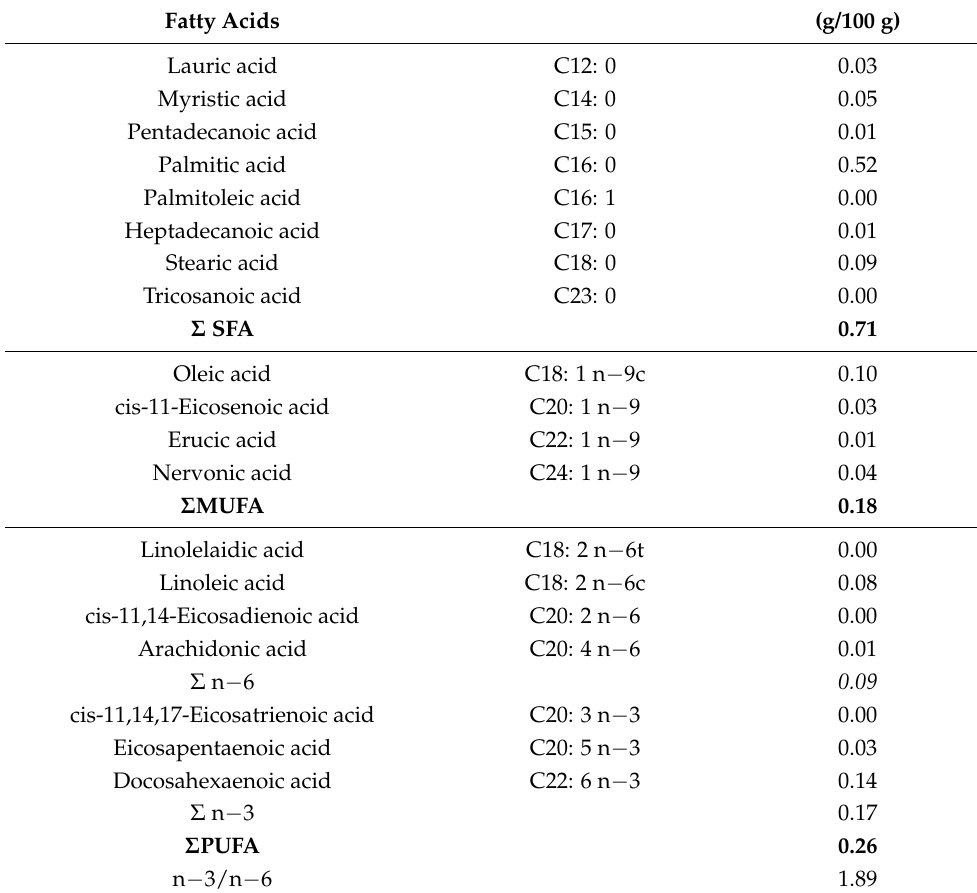
Table 9. Fatty acid contents of test seafood HMR products consisting of a mixture of AMPS, CSM, and